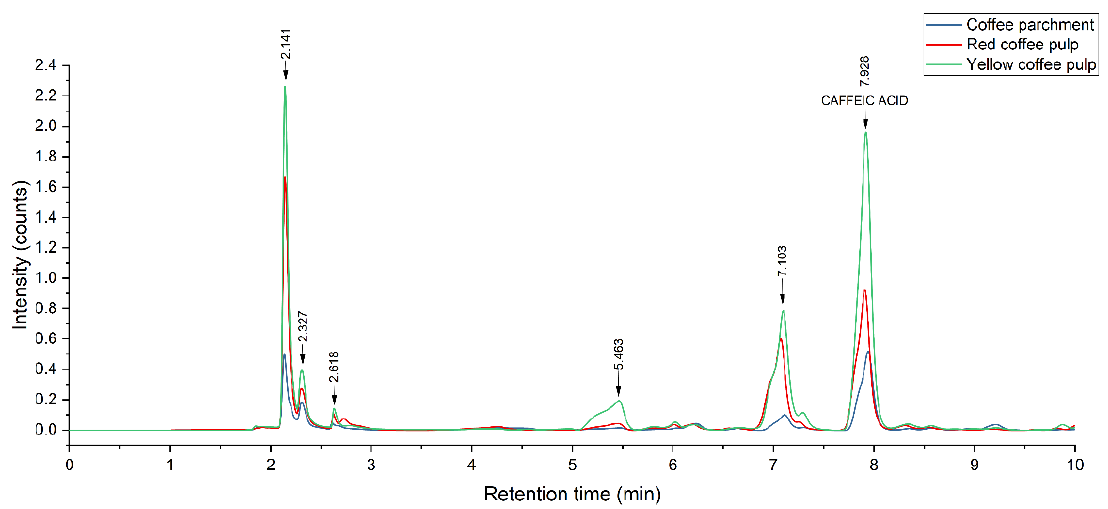
Figure 6. HPLC-DAD chromatographic profile of MAE + PEF treated residues. MAE: Microwave assisted extraction; PEF: Pulsed Electric Field pretreatment.